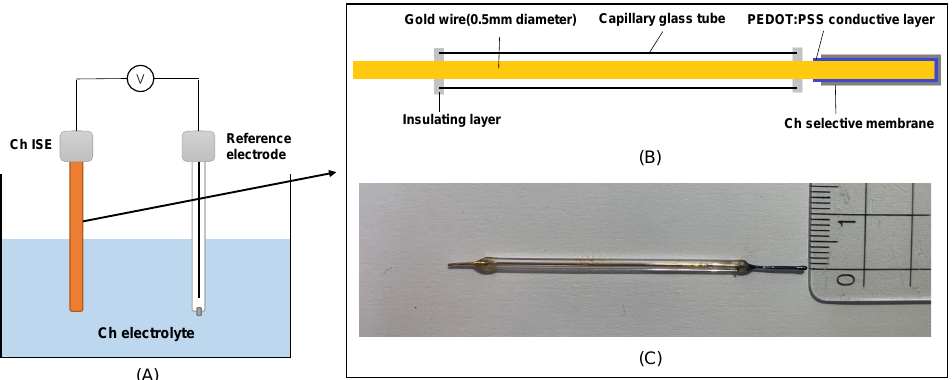
Figure 2. ( A ) Potentiometric detection system in Ch solutions; and ( B ) structure of the Ch all-solid- state ISE; ( C ) photograph of the Ch ISE with a centimeter ruler as a